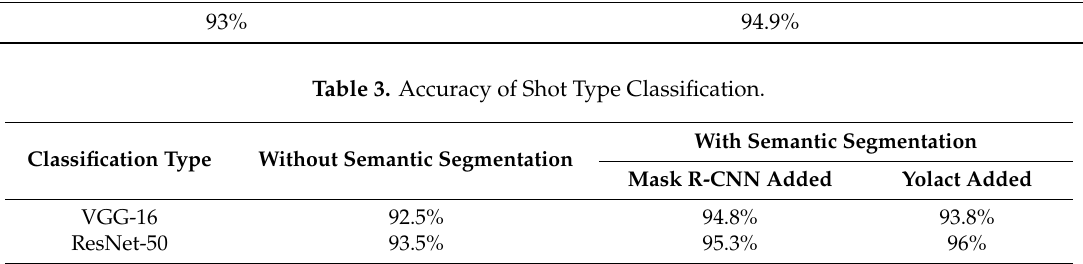
Table 3. Accuracy of Shot Type Classification.